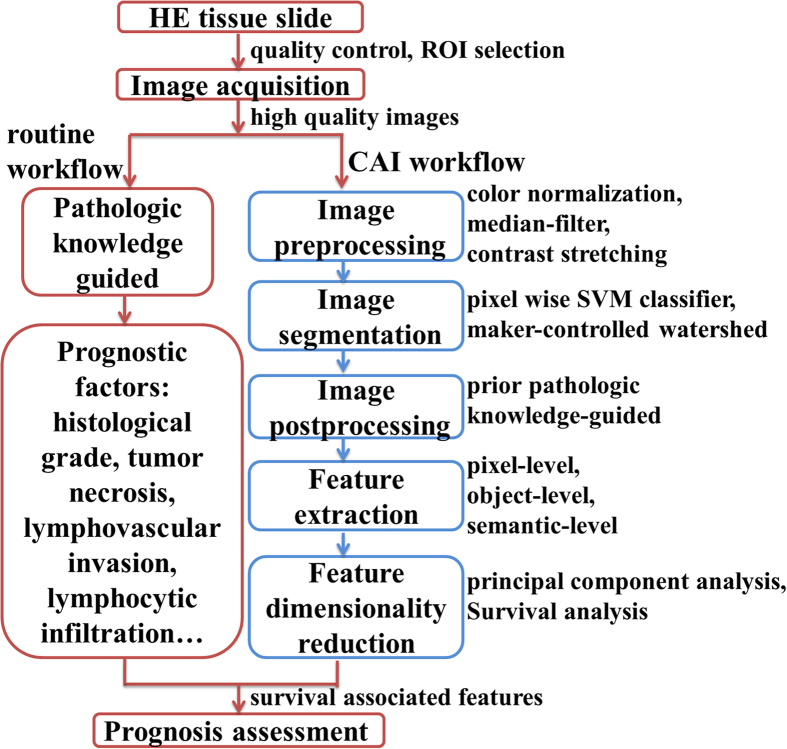
The main steps of computer-aided image analysis (CAI) proposed in this study (blue/right frame) in comparison with traditional histopathology-based prognosis assessment (red/left frame). Image preprocessing was performed to ensure high-quality data are processed. Image segmentation, postprocessing, and feature extraction converted image information into quantitative features. Feature dimensionality reduction was used to explore survival associated features. ROI: the regions of interest, SVM: support vector machine.